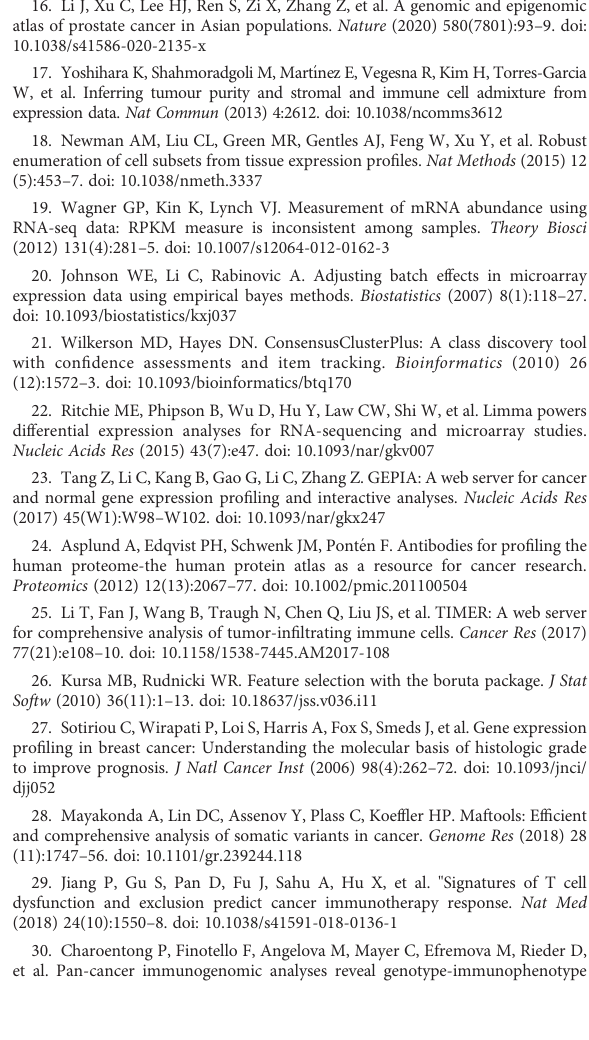
SUPPLEMENTARY FIGURE 5 Correlation between hub genes and immune cell in fi ltration in tumor. (A) Correlation between CNDP2 and major immune cells in patients with prostate cancer (PC). (B) Correlation between SERPINH1 and immune cells in patients with PC. SUPPLEMENTARY FIGURE 6 Status of somatic mutation in patients with prostate cancer (PC). (A) The “ maftools ” R package was used to analyze the somatic gene mutation in patients with PC. (B) A detailed analysis of the variants. (D) The interaction between mutated genes. SUPPLEMENTARY FIGURE 7 Tumor purity and stromal score in prostate cancer (PC) patients. (A, B) Tumor purity (A) and stromal score (B) of immune cell in fi ltration (ICI) clusters. (C, D) The tumor purity (C) and stromal score (D) of gene clusters. (E, F) Tumor purity (E) and stromal score (F) of ICI score. (G) Receiver operatingcharacteristiccurveof ICIcluster,genecluster,andICI score. (H, I) Immune response of ICI score in IMvigor210 and GSE78220 cohorts. CR, complete remission; PR,partial remission; SD, stabledisease; PD, progressive